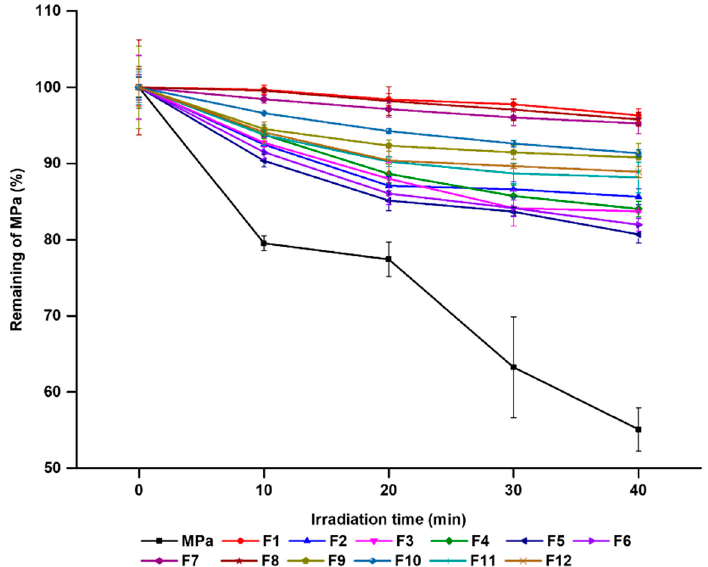
Figure 7. Photostability test using percentage of non-degraded MPa from free MPa solution and MPa-loaded nano-transfersomes before and after irradiation with LED of 2 J/cm 2 for different time intervals of 0, 10, 20, 30, and 40 min. Results are expressed as means ± standard deviations of three independent experiments ( n = 3).